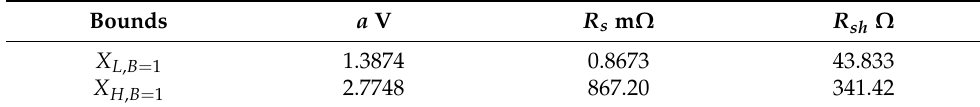
Table 1. Initial parameter limits for the KC200GT SPVM using ϕ = 1%.